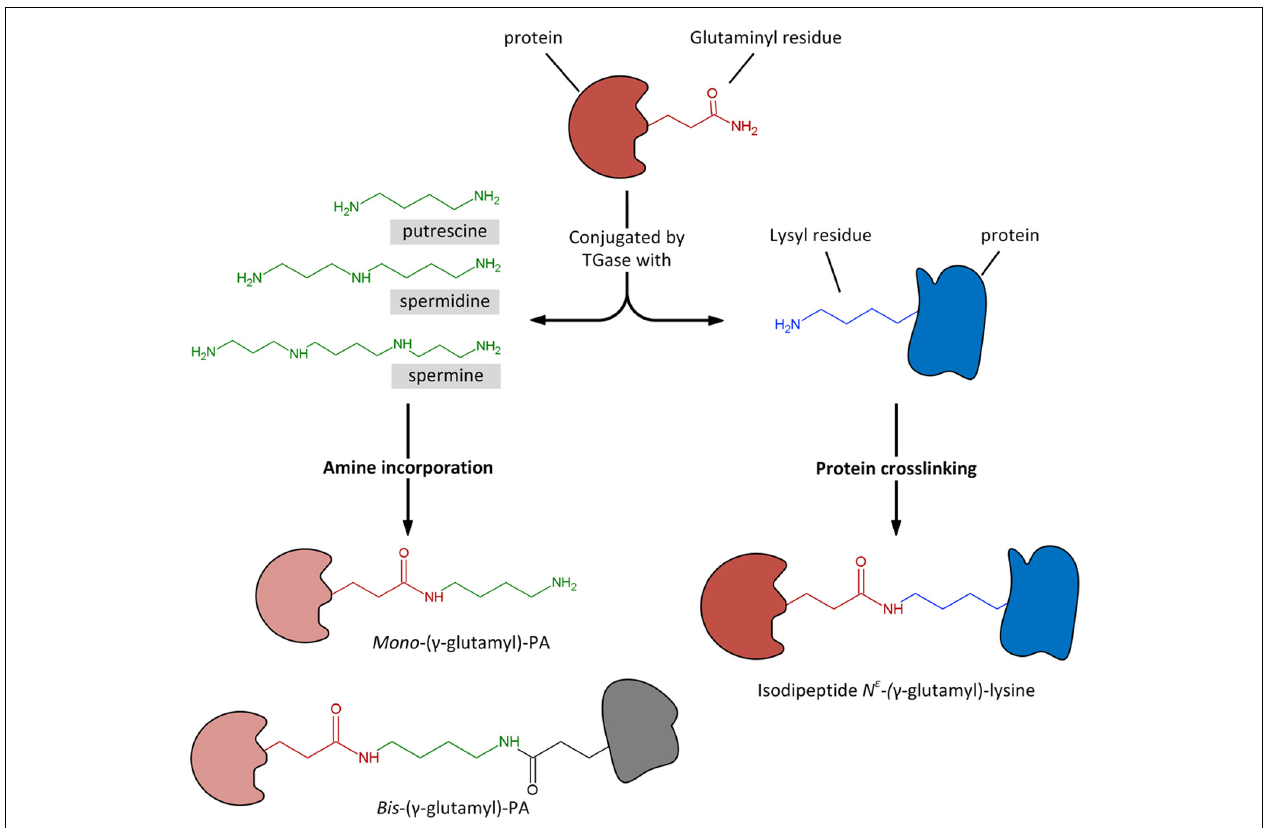
FIGURE 2 |Transglutaminase could catalyze the Ca 2+ -dependent incorporation of substrates having a primary amino group, as polyamines, to the γ -carboxamide group of a specific protein-bound glutaminyl residue, giving rise to mono - and bis -( γ -glutamyl)-PAs.